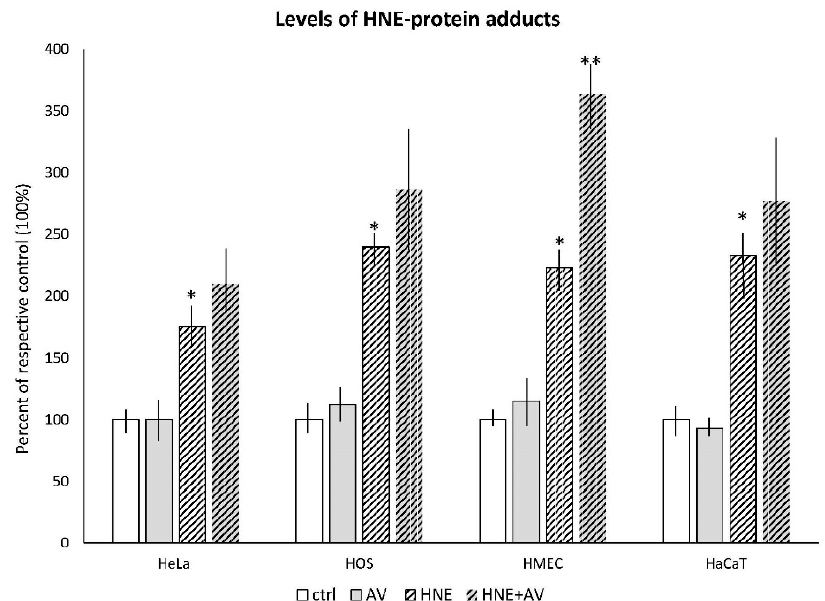
Figure 6. The effects of AV extract (1%) on the cellular generation of 4-hydroxynonenal (HNE)–protein adducts induced by HNE treatment (50 µ M). The amounts of HNE–protein adducts were determined by cell-based HNE–His ELISA and are given as mean values for triplicates. * significant difference to respective untreated control (ctrl); ** significant difference to respective HNE-treated control.